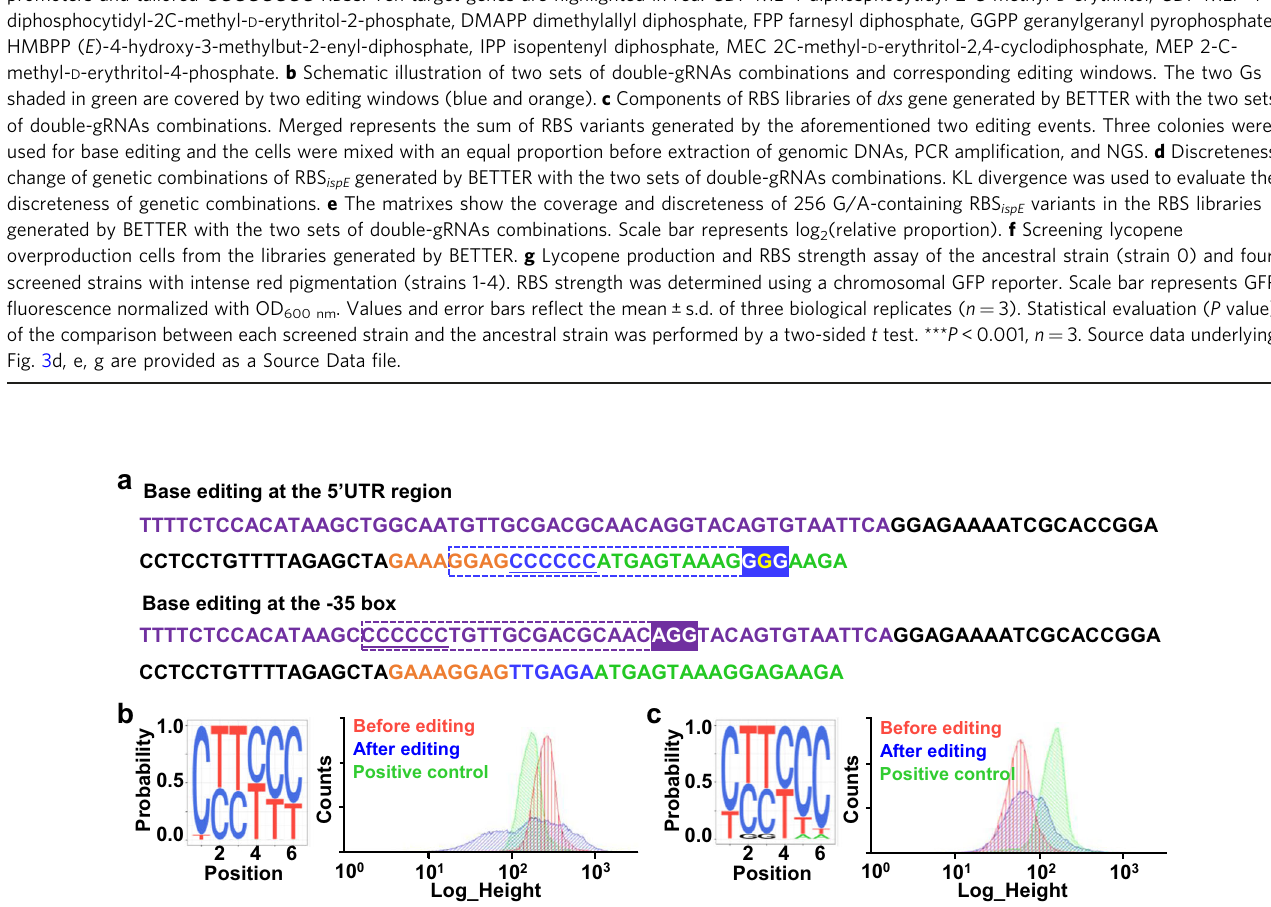
Fig. 4 Diversifying 5 ′ UTR and promoter by BETTER for regulating gene expression. a Design of base editing targets by replacing the original 5 ′ UTR between RBS and start codon and − 35 box of the promoter to six consecutive Cs, respectively. The target Cs are underlined. The N20 sequences of gRNA are denoted with the dotted box. PAMs for 5 ′ UTR and promoter editing are shaded in blue and purple, respectively. The mutated G for the generation of a GGG PAM is highlighted in yellow. The original sequence for gfp expression cassette is shown in Supplementary Fig. 1. b , c Analyses of the 5 ′ UTR ( b ) and − 35 box ( c ) libraries by NGS and fl ow cytometry. Three colonies were used for base editing and the cells were mixed with an equal proportion before extraction of genomic DNAs, PCR ampli fi cation, and NGS. The original gfp expression cassette was used as a positive